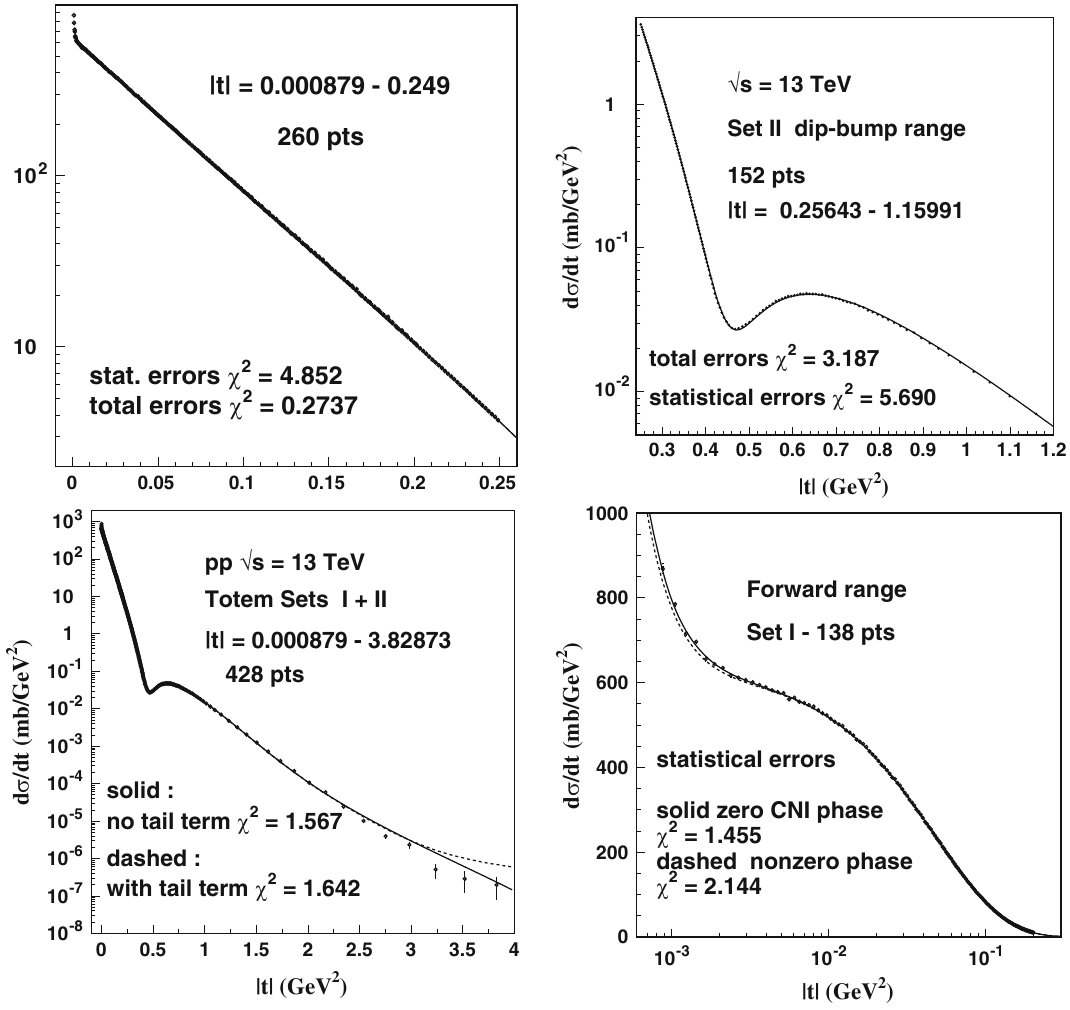
√ s = 27 . 4GeV. In the small- and mid- | t | ranges of plots a large | t | at and b the influence of the tail term is not relevant in the plots. In plot d for small | t | we show lines for calculations with Coulomb-nuclear interference phase φ included in the usual form (dashed line), and with phase put as zero (solid line); numbers are given in Table 4